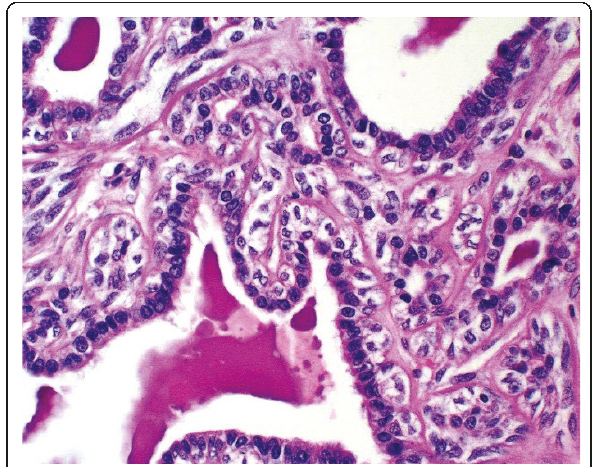
Figure 2 Two cellular components are recognized, one of cuboid epithelial cells that line tubules and cysts, with eosinophilic cytoplasm and central nucleus, with patentnucleolus; the other component is from myoepithelial lineage and lies under the former; it consists of polygonal cells with abundant clear cytoplasm .